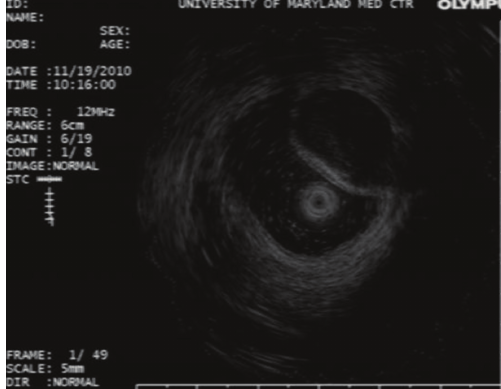
Figure 4: EUS image showing an anechoic structure within the appendix in Case